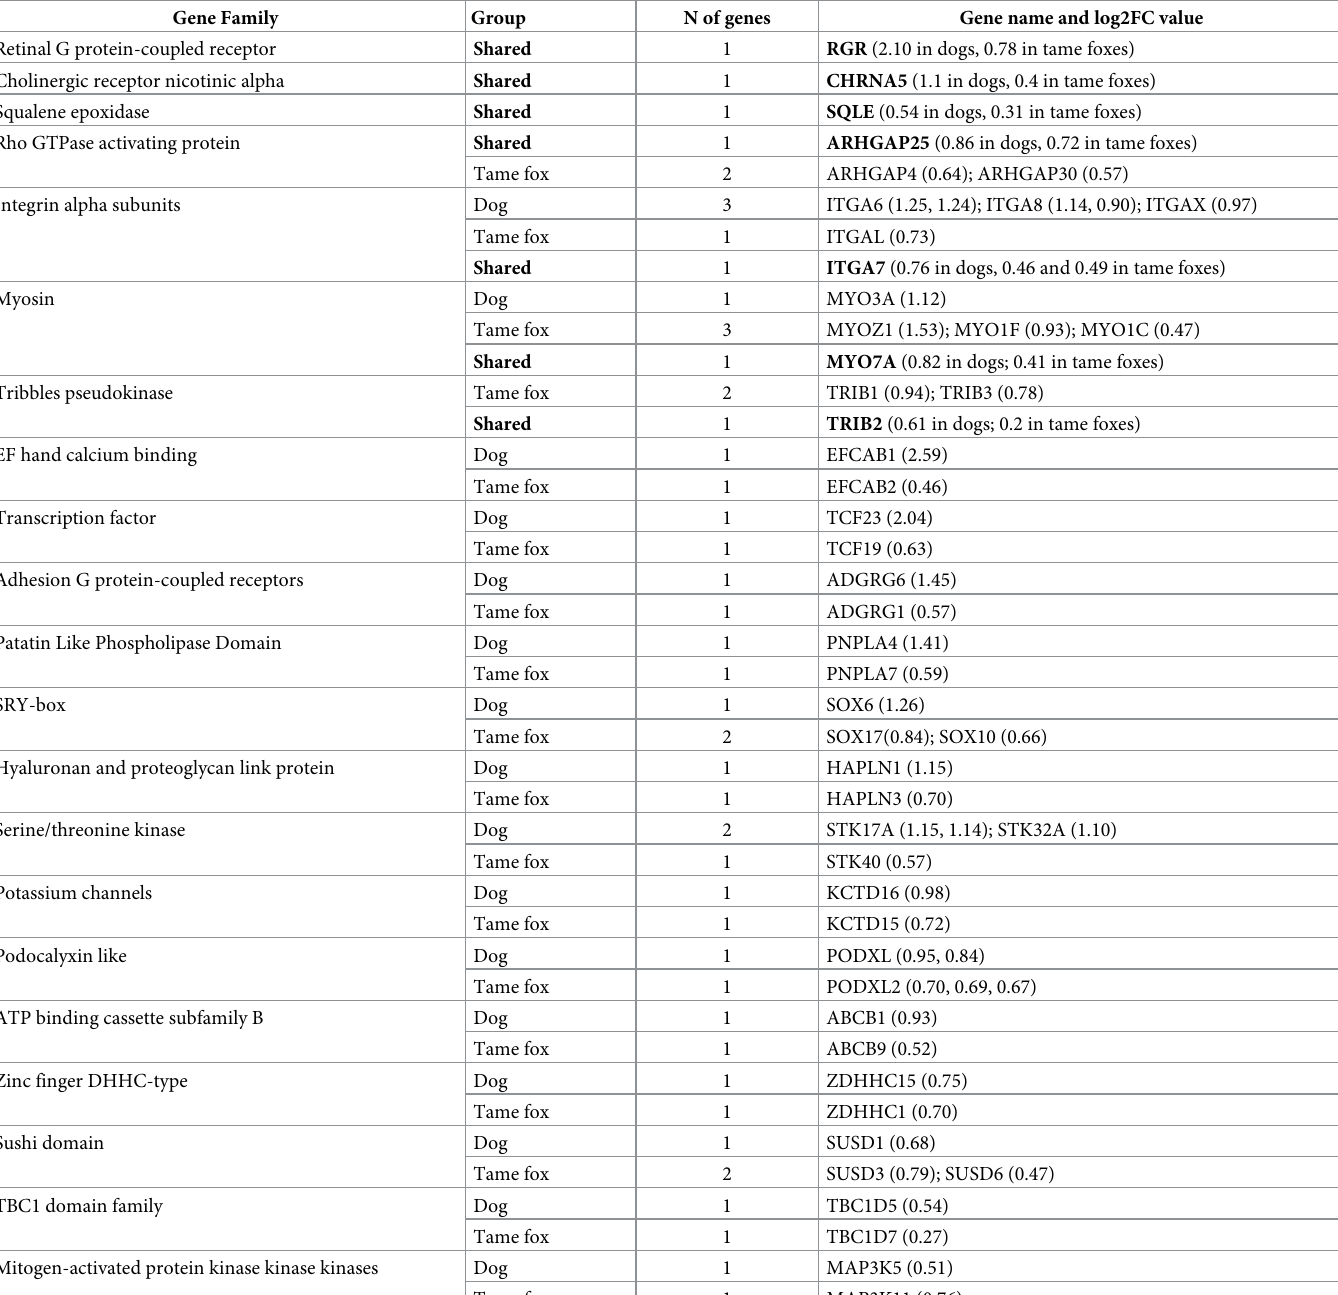
Table 1. Shared genes and gene families (Up regulation). List of the gene families, and shared genes, that were commonly up regulated in dogs and tame foxes. The number, and name, of the genes within each gene family are provided, with the corresponding log2fold-change values in brackets for each species. Within each family, sin- gle genes were charecterized as shared between dogs and tame foxes (bold), or as exclusively to each of the two groups. When more than one transcript for a specific gene was present, all the log2FC values are